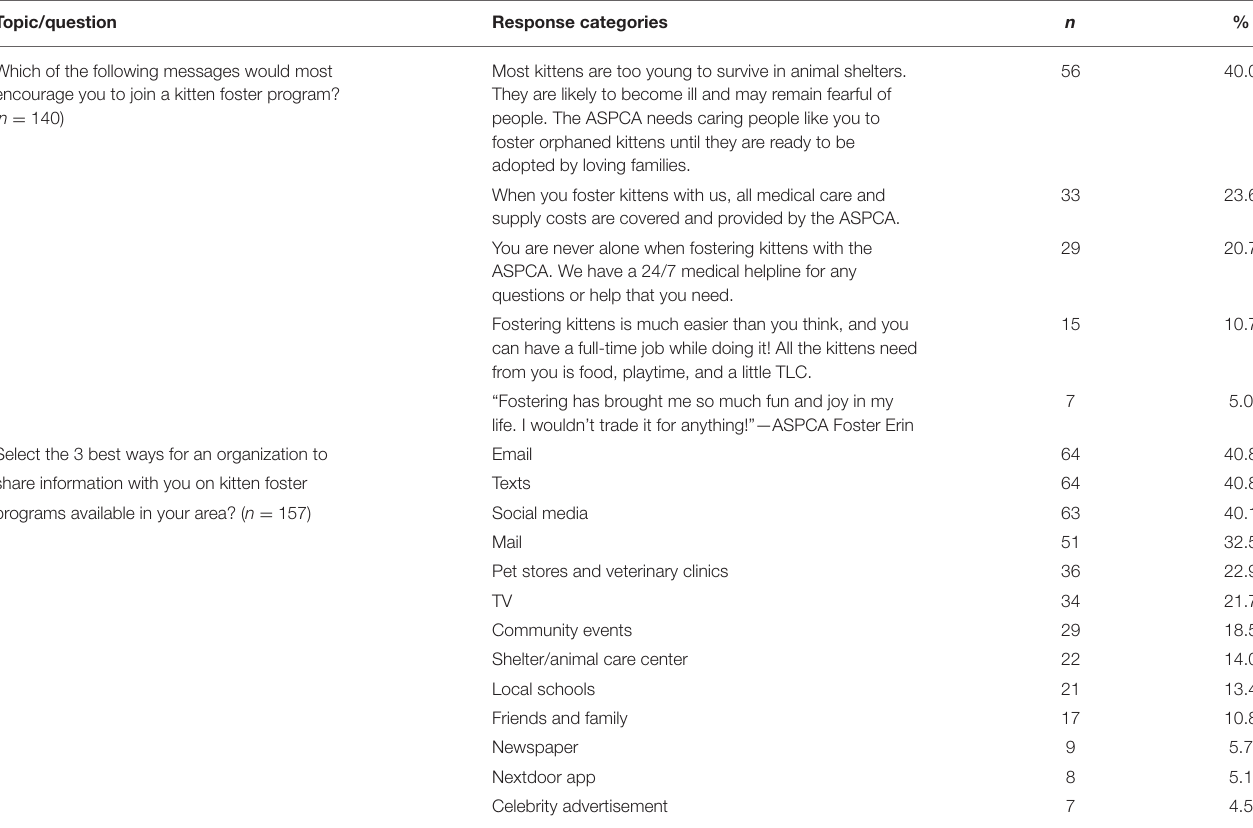
TABLE 7 | Perception of potential marketing/messaging and preferred communication methods.